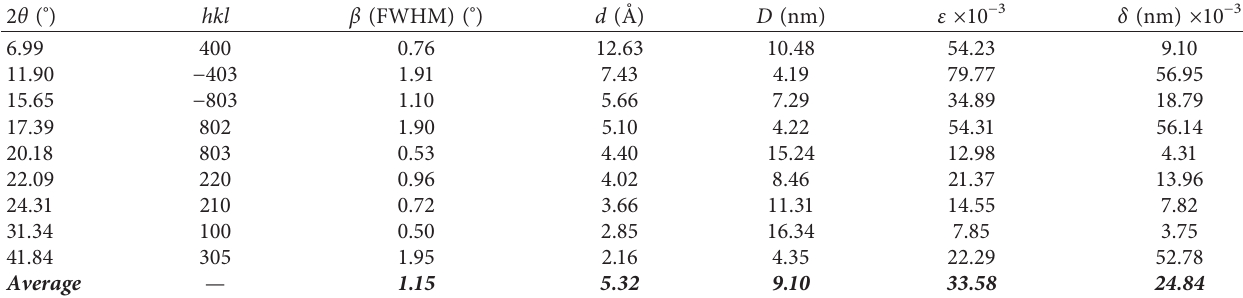
Table 5: Powder X-ray data of Zn(II)